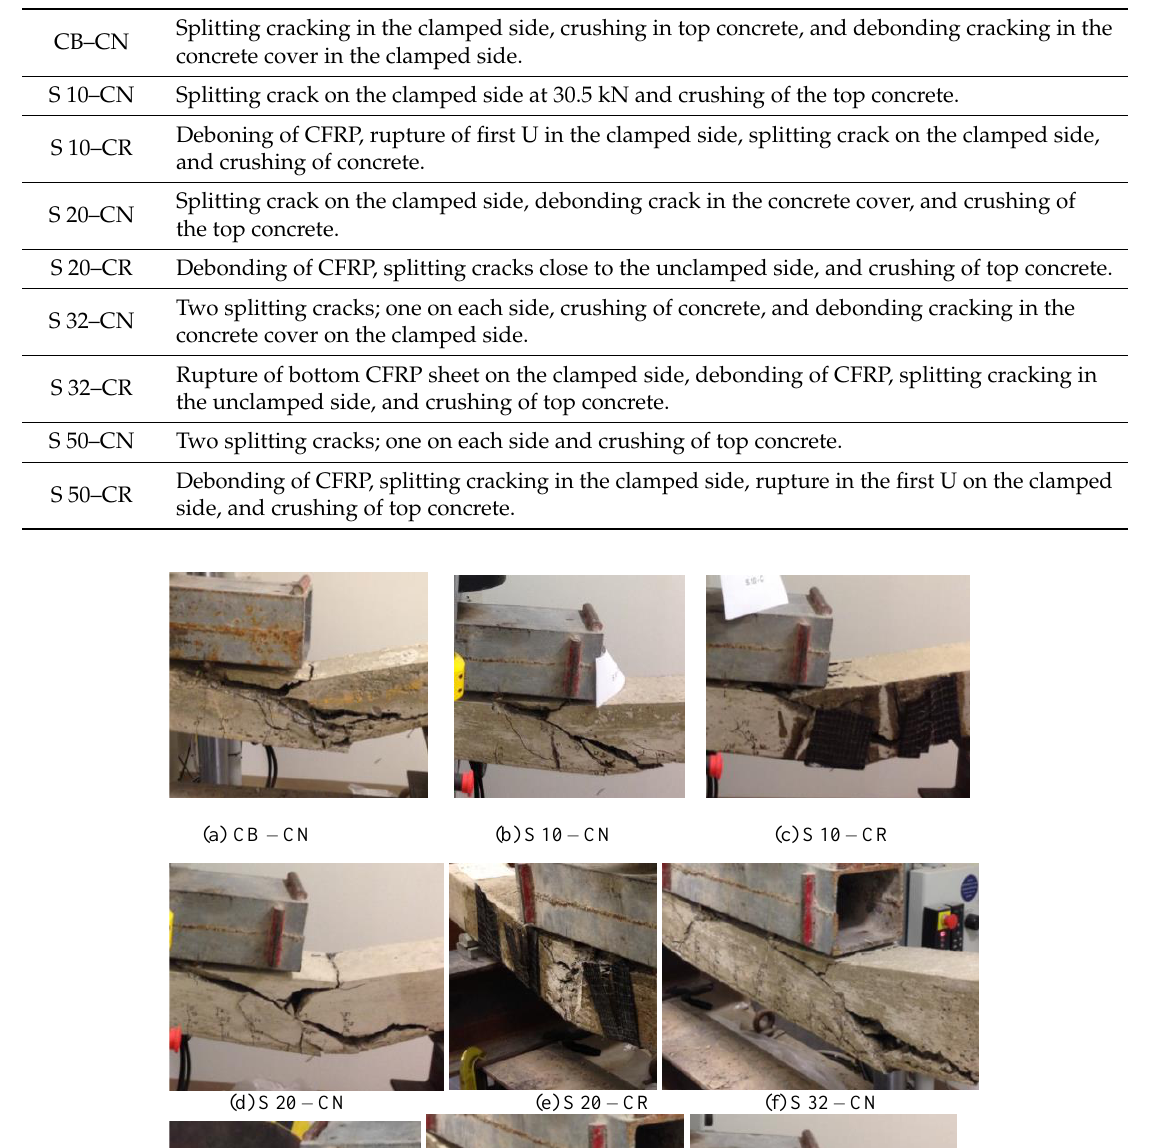
Table 7. Failure description of control beam and beams with simulated corrosion.